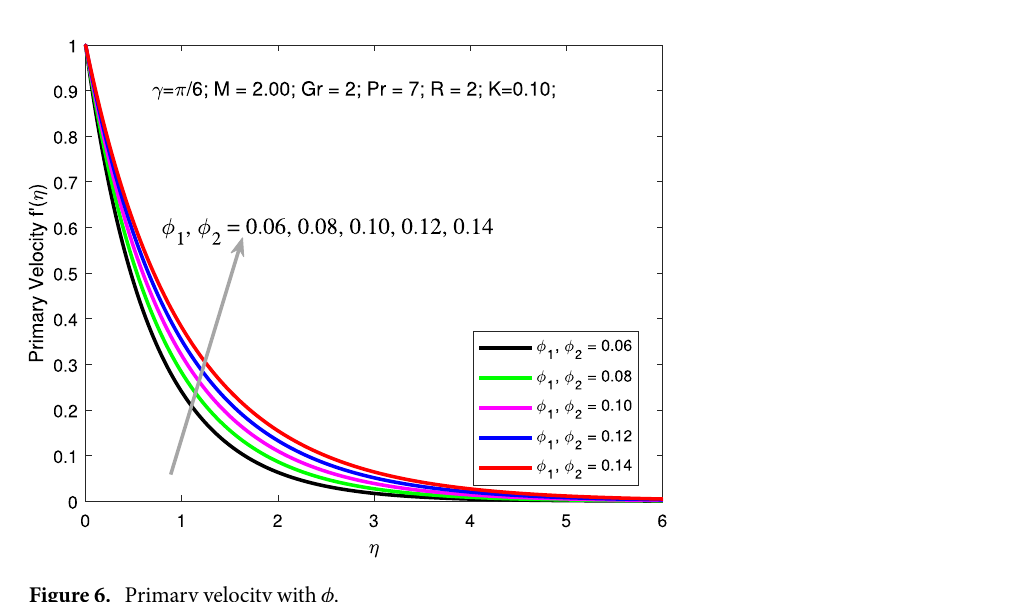
Figure 6. Primary velocity with φ